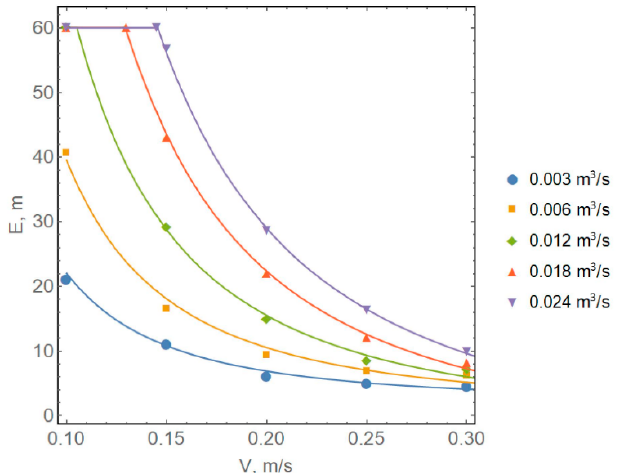
Figure 7. Methane cloud length E as a function of air velocity for four different methane emission intensities; the dots show the numerical solution, the solid lines show the approximating function